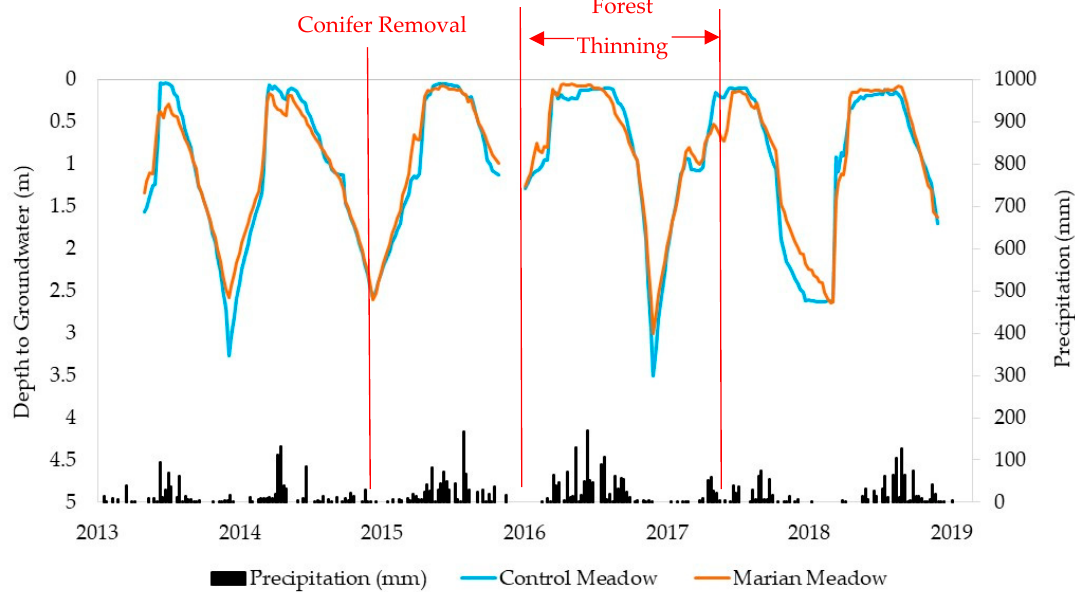
Figure 5. Average weekly depth to groundwater (m) and precipitation (mm) for the Control Meadow and Marian Meadow, 2013–2019. Break in 2016 time series indicate groundwater depths below shallow well depths including a year without ERT imaging for interpretation. In 2018, deeper wells were added.